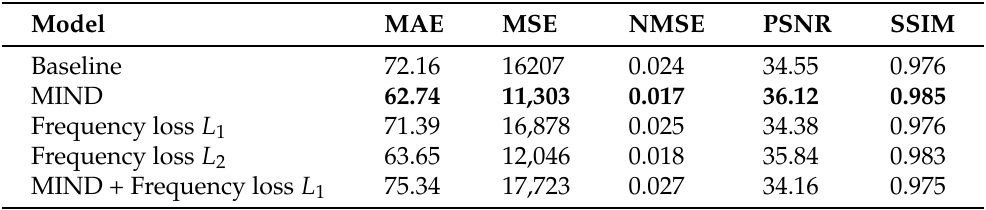
Table 3. Image similarity metrics on the phantom for experiments with various structure losses. All metrics were computed between images with their intensities expressed on the HU scale and clipped into the range [0, 3000]. The best value per metric is highlighted in bold